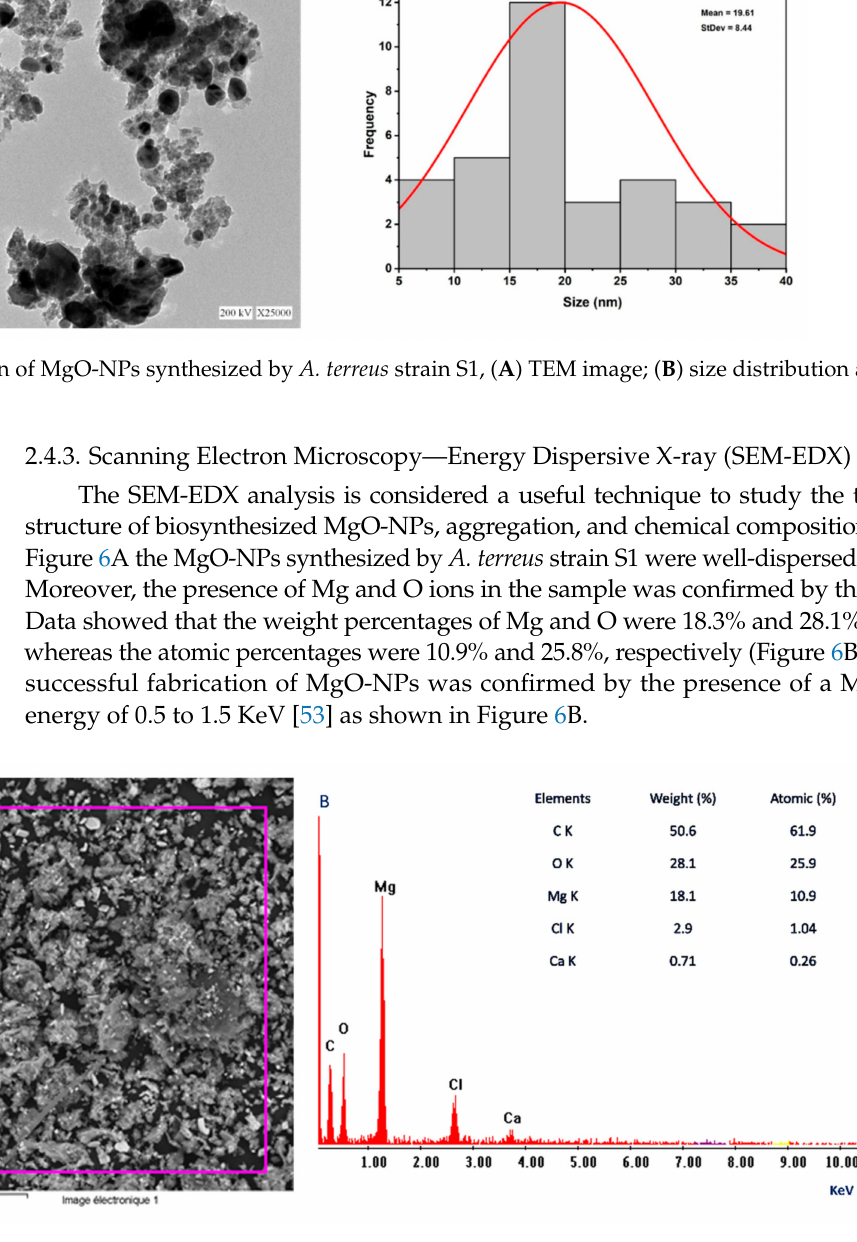
Figure 6. Characterization of MgO-NPs synthesized by A. terreus strain S1, ( A ) SEM image; ( B ) EDX